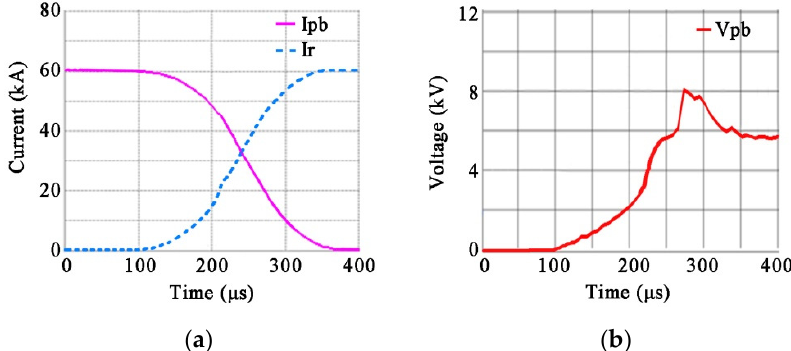
Figure 8. Pyro-breaker tested at 60 kA: ( a ) Current oscillogram; ( b ) Voltage oscillogram.